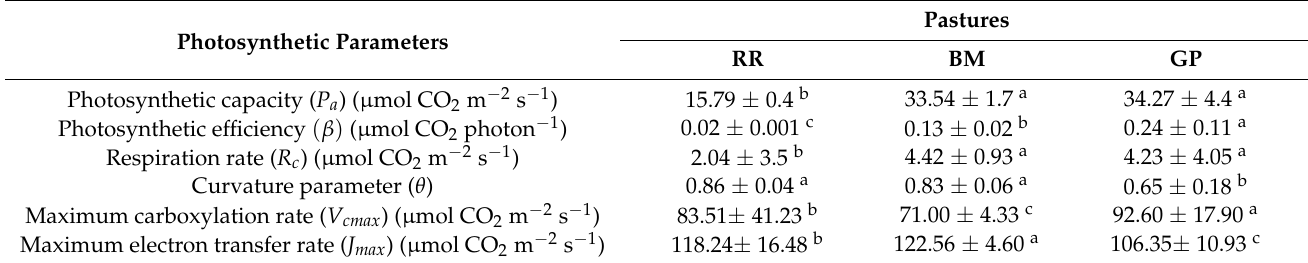
Table 2. Pasture species effects of photosynthetic CO 2 response parameters of tropical pastures (means of four plots) measured on 12 February 2021 at Gatton Research Dairy, Queensland, Australia.